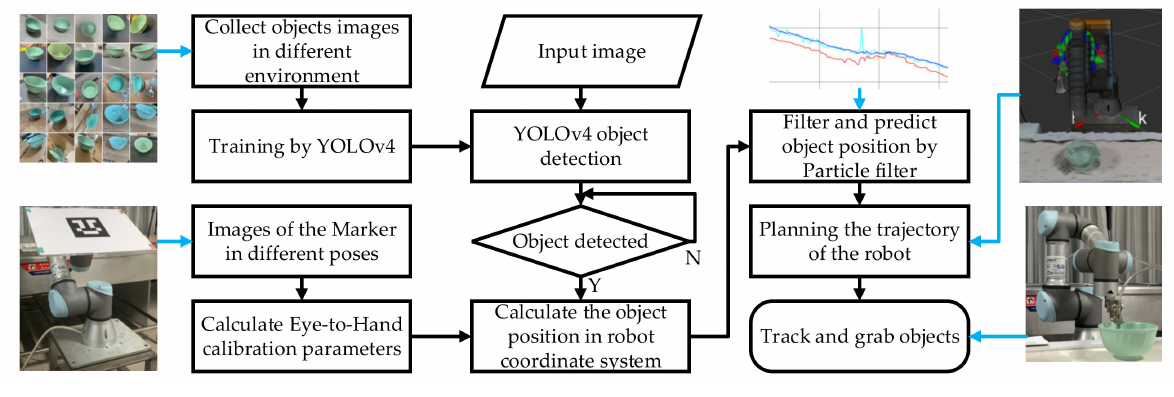
Figure 1. Overall flow